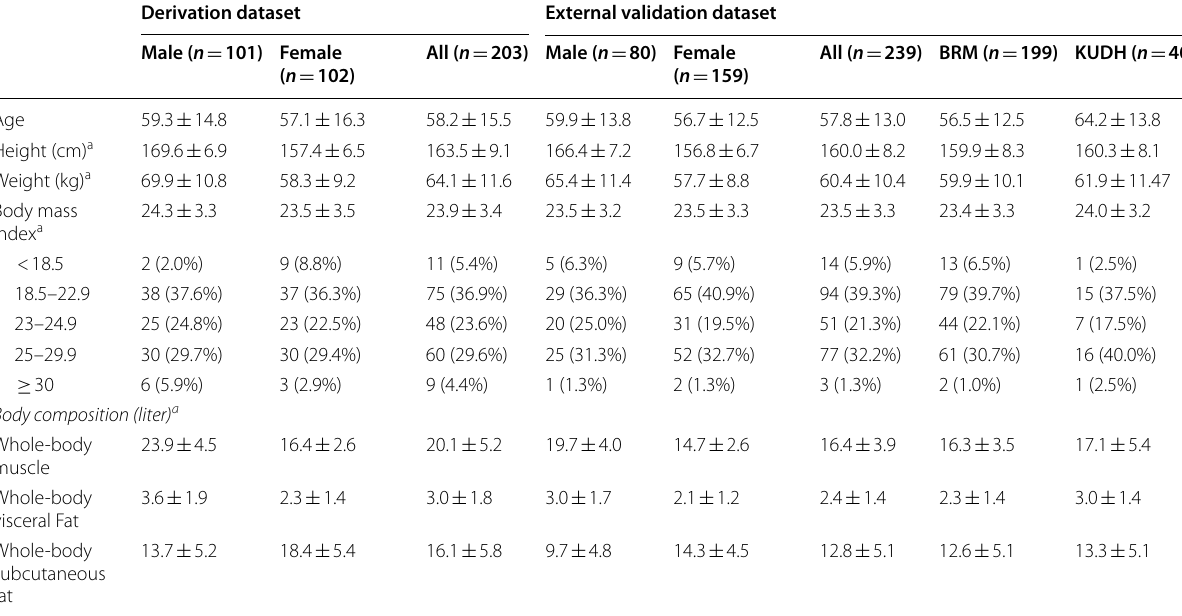
Table 1 Participants’ characteristics in the derivation and validation datasets